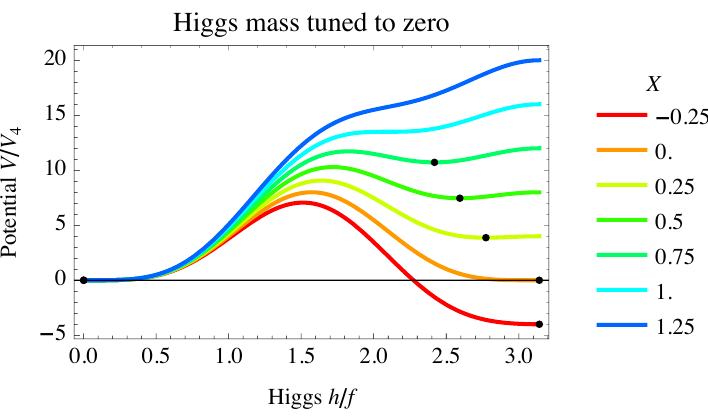
Figure 1 . Possible composite Higgs potentials with lowest-frequency terms for di(cid:11)erent values of the free parameter X de(cid:12)ned in eq.